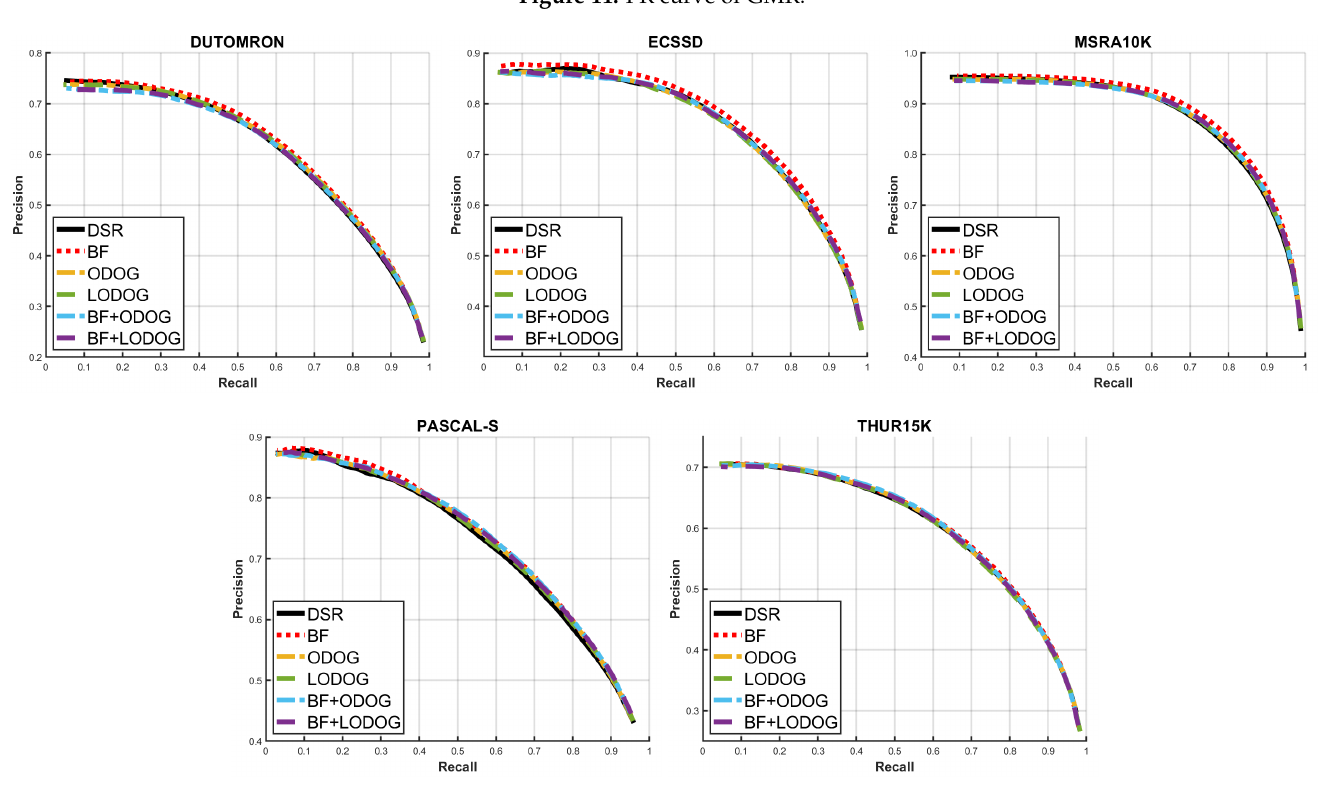
Figure 11. PR curve of GMR.